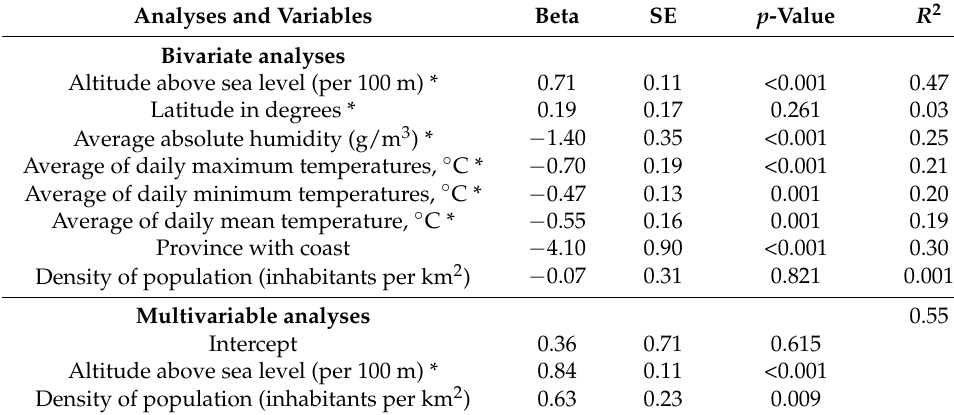
Table 2. Results of linear regression at the province level ( n = 50) between environmental and demographic variables and the seroprevalence of IgG antibodies against SARS-CoV-2 obtained by